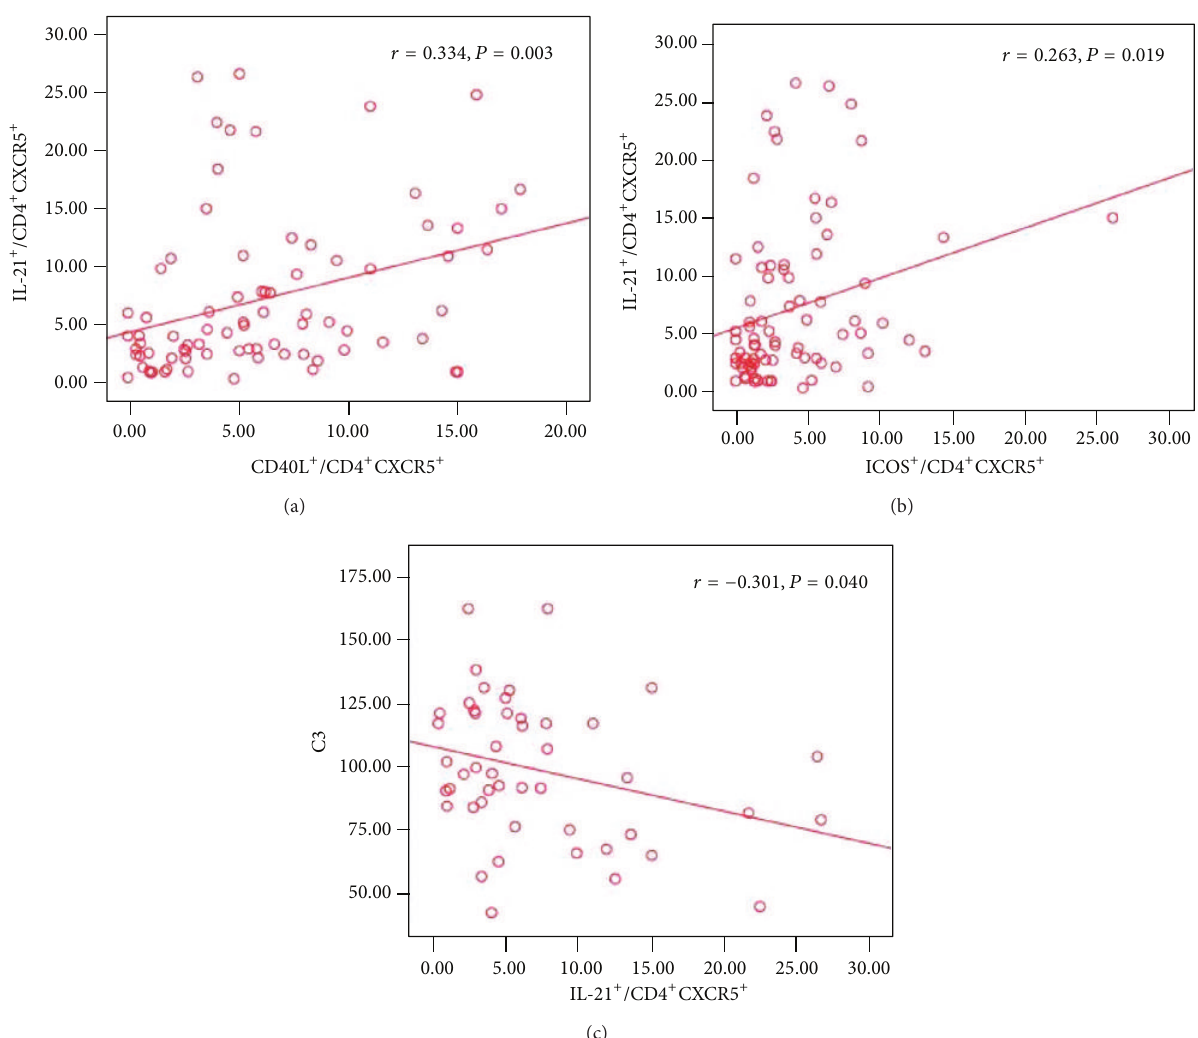
Figure 5: Correlation of the ratio of CD4 + CXCR5 + IL-21 + cells with the frequency of Tfh cells in BM in IRP patients. (a) Relationship between the ratio of CD4 + CXCR5 + IL-21 + cells and the ratio of CD4 + CXCR5 + CD40L + cells. (b) Relationship between the ratio of CD4 + CXCR5 + IL-21 + cells and the ratio of CD4 + CXCR5 + ICOS + cells. (c) Relationship between the ratio of CD4 + CXCR5 + IL-21 + cells and the level of serum C3 in IRP